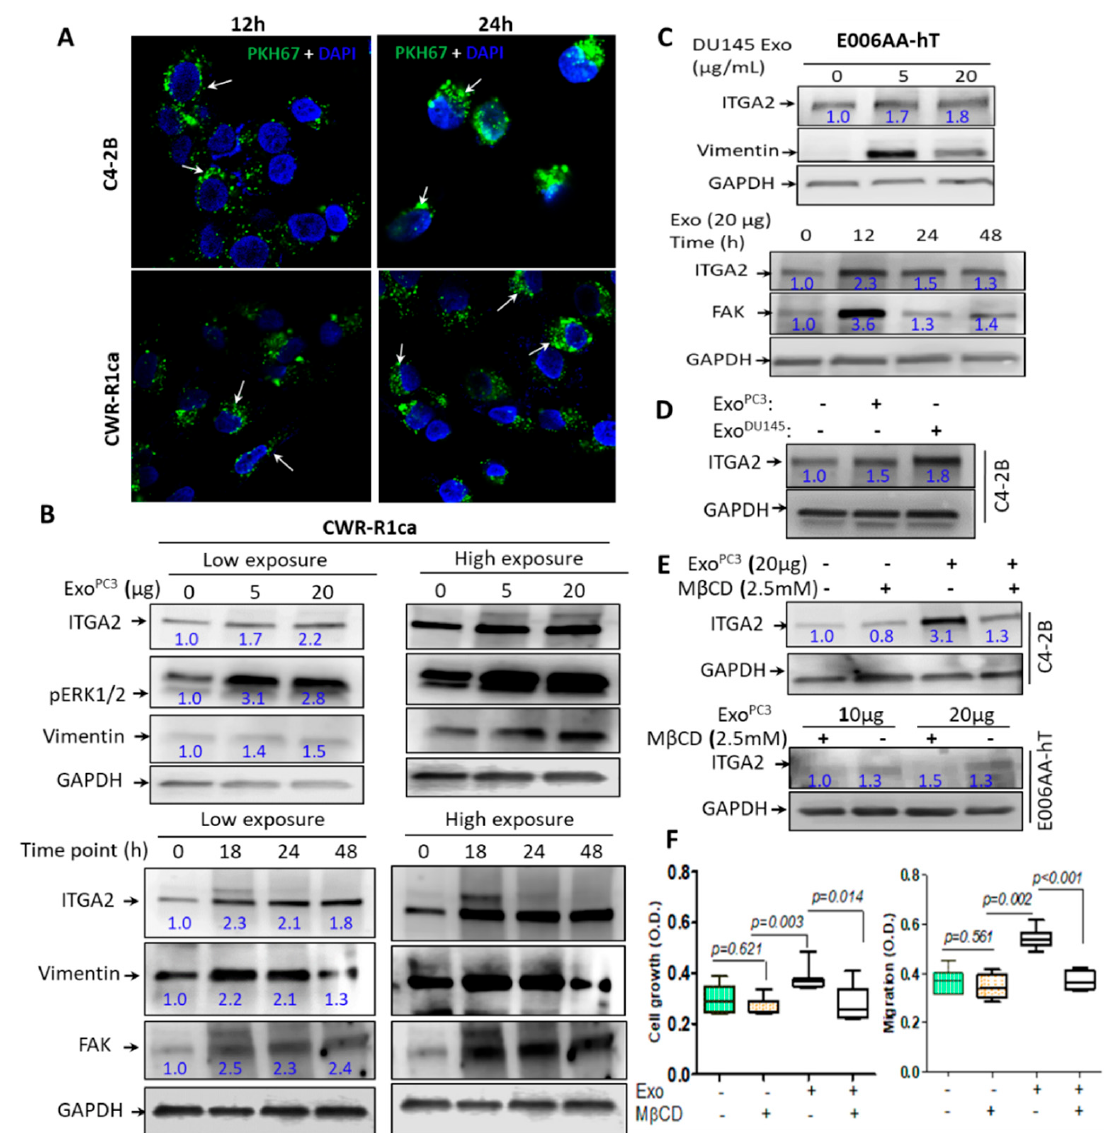
Figure 2. Exosomes-mediated transfer of ITGA2 in PCa cells. ( A ) Exosomal uptake of exosomes derived from PC-3 (Exo PC3 , 10 µ g / mL) labeled with PKH67 in C4-2B and CWR-R1ca cells. The green color of microbodies indicates exosomal uptake by recipient cells, and the blue color represents nuclear staining by DAPI. ( B , C ). Optimization of exosomes-mediated transfer in recipient cells. About 20 µ g protein lysates were collected from CWR-1Rca ( B ) and E006AA-hT ( C ) cells, after their incubation with 0, 5, and 20 µ g / mL Exo PC-3 for 48 h. Meanwhile, 20 µ g protein lysate collected from CWR-1Rca and E006AA-hT cells previously incubated with 20 µ g / mL Exo PC-3 for 18, 24, and 48 h. The membranes were probed with anti-ITGA2, anti-vimentin, anti-FAK and anti-pERK1 / 2 antibodies in addition to anti-GAPDH as a loading control protein. ( D ) Immunoblot (IB) analysis for C4-2B cells incubated with 20 µ g / mL exo PC-3 for 24 h showing ITGA2 expression. ( E ) IB analysis for protein lysate collected from C4-2B and E006AA-hT cells treated without or with 2.5 mM M β CD in the presence of 20 µ g / mL exo PC-3 . ( F ) CWR-1Rca cells were treated with exo PC − 3 with or without 2.5 mM M β CD for cell proliferation (72 h) and cell migration (24 h). The experiments were repeated at least twice. Data are statistically significant at p <